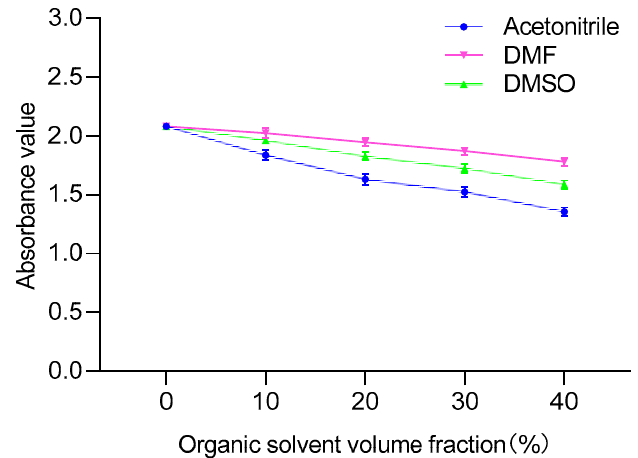
Figure 3. Comparison of different organic solvents. Table 1. Comparison of different DMF and DMSO contents.